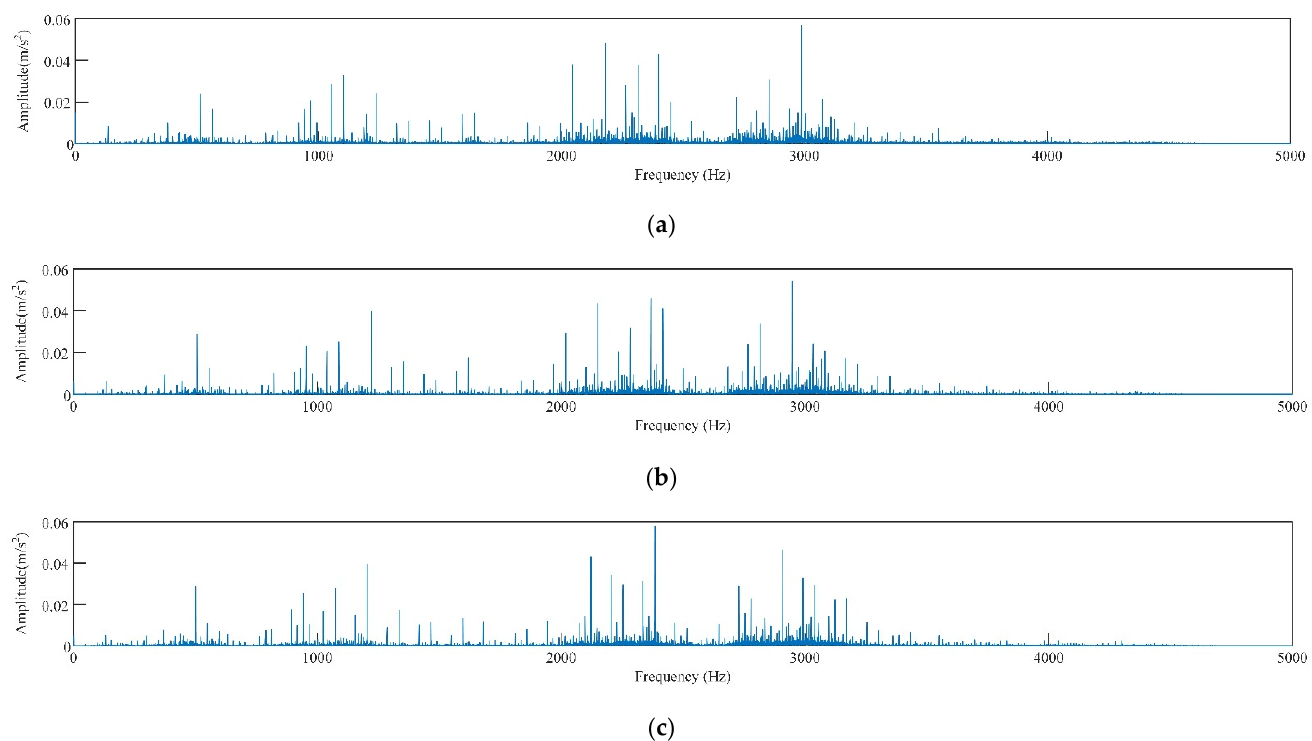
Figure 6. Frequency domain diagram of vibration signal of rolling bearing with inner ring fault under different loads, ( a ) 0HP, ( b ) 1HP, ( c )